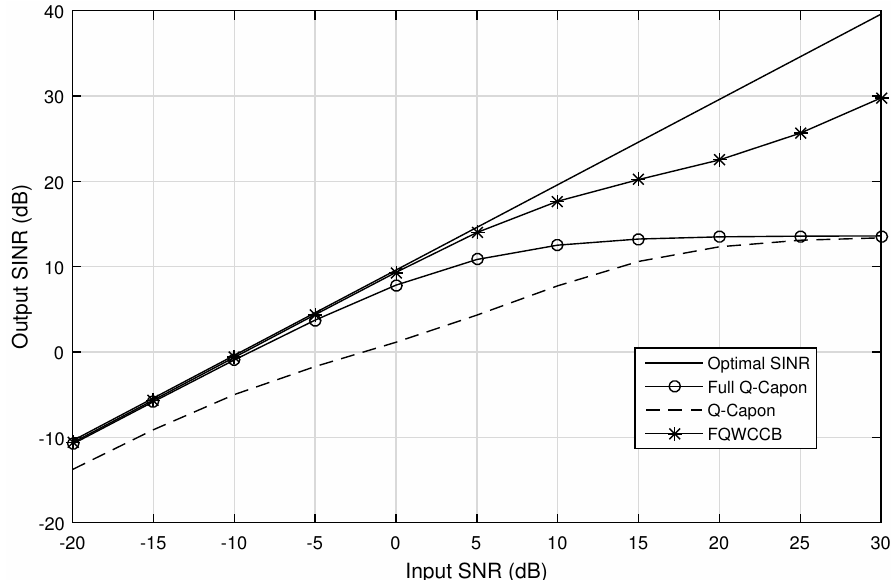
Figure 6. Output signal-to-interference-plus-noise ratio (SINR) versus input signal-to-noise ratio (SNR) for snapshots number 100, without steering vector mismatch.